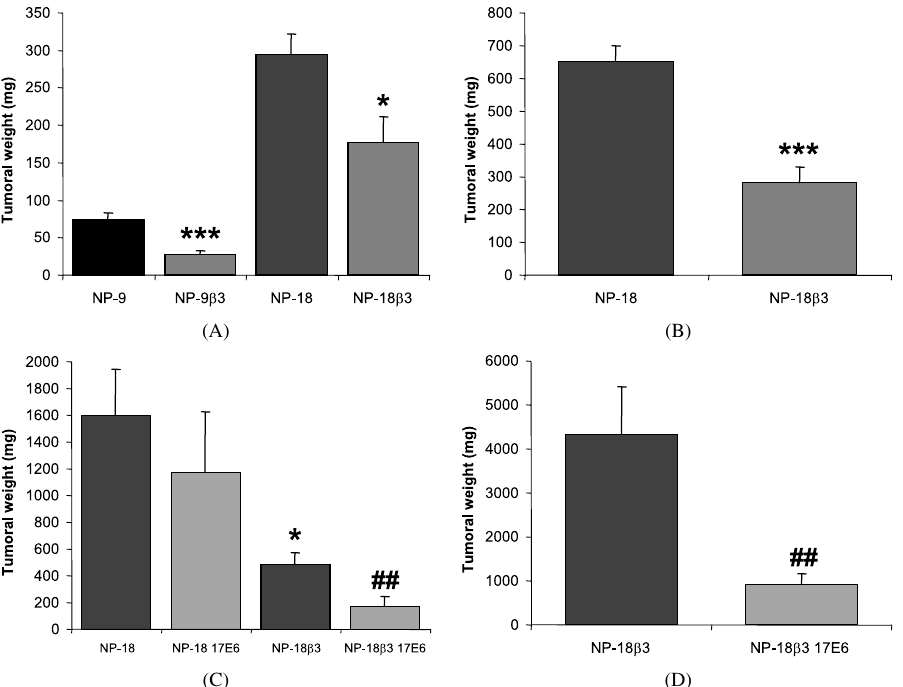
Fig. 6. Tumor growth and treatment with the 17E6 antibody. (A) Tumor growth into subcutaneous tissue. A total of 12 × 10 6 NP-9 or NP-9 β 3 and 5 × 10 6 NP-18 or NP-18 β 3 tumor pancreatic cells were injected subcutaneously into each posterior flank region of BALB/c nu/nu mice. After sacrifice, tumors were extracted and weighed. Bars represent means ± SD of tumor weights from 6–8 mice/condition. Statistics: t -test, * p (cid:2) 0 . 05, NP-18 vs. NP-18 β 3 *** p (cid:2) 0 . 001 NP-9 vs. NP-9 β 3 . (B) Tumor growth into pancreas. After 5 weeks of implantation of 10 mg tumor fragments by subcostal laparatomy, animals were sacrificed. Tumors were extracted and weighted. Bars represent means ± SD of tumor weights from 4–7 mice/condition. Statistics: t -test, *** p (cid:2) 0 . 001 NP-18 vs. NP-18 β 3 . (C) Effects of 17E6 on subcutaneous tumors. Cells were injected s.c. in nude mice, as described for A. The mAb, 17E6 (1 mg/animal), or PBS were administered three times per week over six weeks from the first day. Next, animals were sacrificed and tumor weights determined. Bars show means ± SD of tumor weights from 4–6 mice/condition. Statistics: t -test, * p (cid:2) 0 . 05 untreated NP-18 vs. untreated NP-18 β 3 , ## p (cid:2) 0 . 01 untreated NP-18 β 3 vs. 17E6-treated NP-18 β 3 . (D) Effects of 17E6 on intrapancreatic tumors. Tumor fragments were implanted in mouse pancreas, as described for (B). The mAb, 17E6 (500 µg/animal), or an equal volume of PBS was administered three times per week over 7 weeks from the seventh day after implantation. Next, animals were sacrificed and tumor weights determined. Bars depict means ± SD of tumor weights from 5–8 mice/condition. Statistics: t -test, ## p (cid:2) 0 . 01 untreated NP-18 β 3 vs. 17E6-treated NP-18 β 3